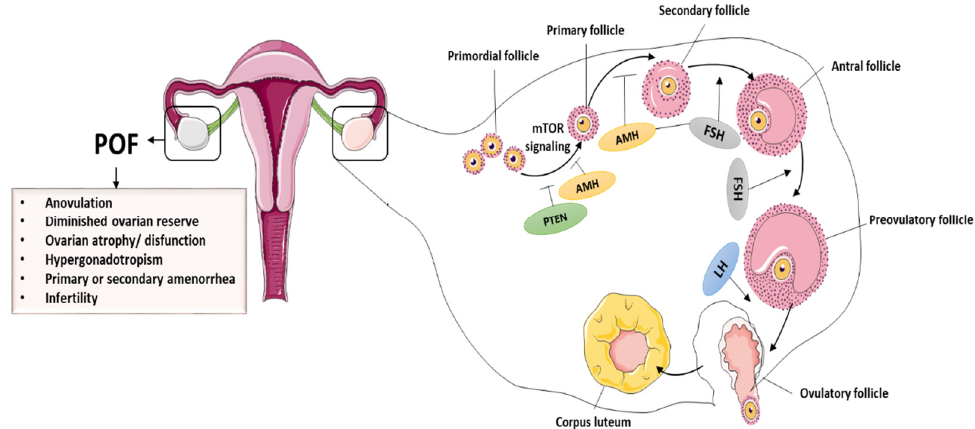
Figure 1. An illustration presenting normal folliculogenesis and symptoms of POF.